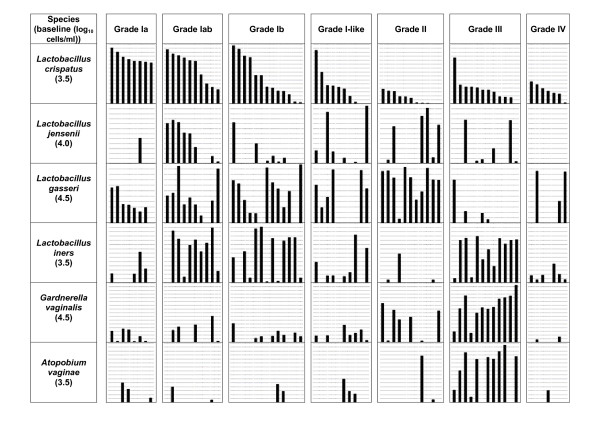
Overview of the results obtained with real-time PCR for L. crispatus, L. jensenii, L. gasseri, L. iners, G. vaginalis and A. vaginae. x-axis: each bar represents a different sample. y-axis: logarithmic scale of cells/ml. Spaces in between horizontal lines represent log10 0.5 differences. Detection limits are 3.5 for L. crispatus, 4.0 for L. jensenii, 4.5 for L. gasseri, 3.5 for L. iners, 4.5 for G. vaginalis and 3.5 for A. vaginae. Data sorted per grade according to decreasing concentration of L. crispatus.